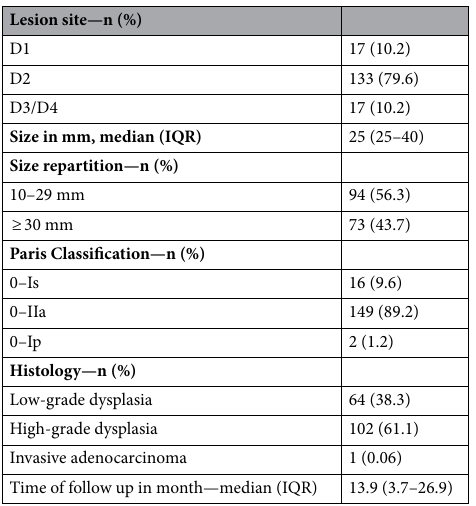
Table 2. Baseline lesions characteristics. D1: First duodenum; D2 Second duodenum; D3/4: third/fourth duodenum; n: number; mm: millimeter; IQR: Interquartile range.